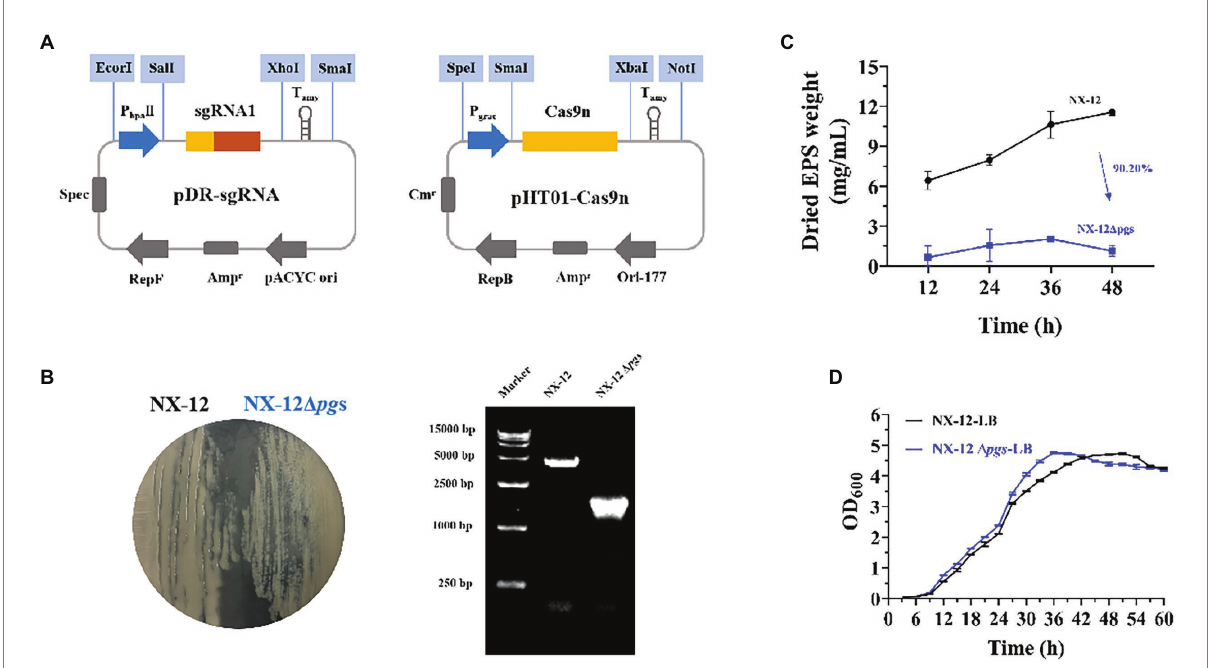
FIGURE 3 Knockout of pgsBCA based on CRISPR-Cas9n system. (A) Construction of double plasmid system; (B) Comparison of colony morphology and verification by PCR after knockout; (C) Yield of EPS between NX-12 and NX-12 Δ pgs ; (D) Growth curves of NX-12 and NX-12 Δ pgs in LB medium.